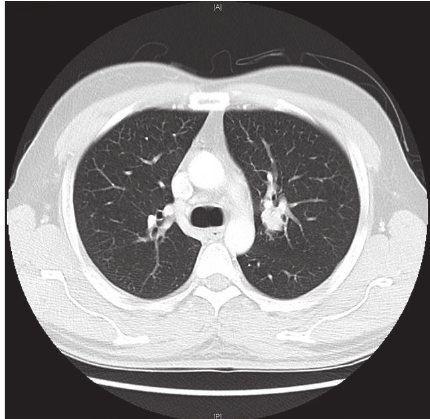
Figure 4: Follow-up CT chest redemonstrated the same lobulated round mass in the left upper lobe which is almost stable from the previous study. The mass is surrounded by ground glass opacity which is almost stable from the previous